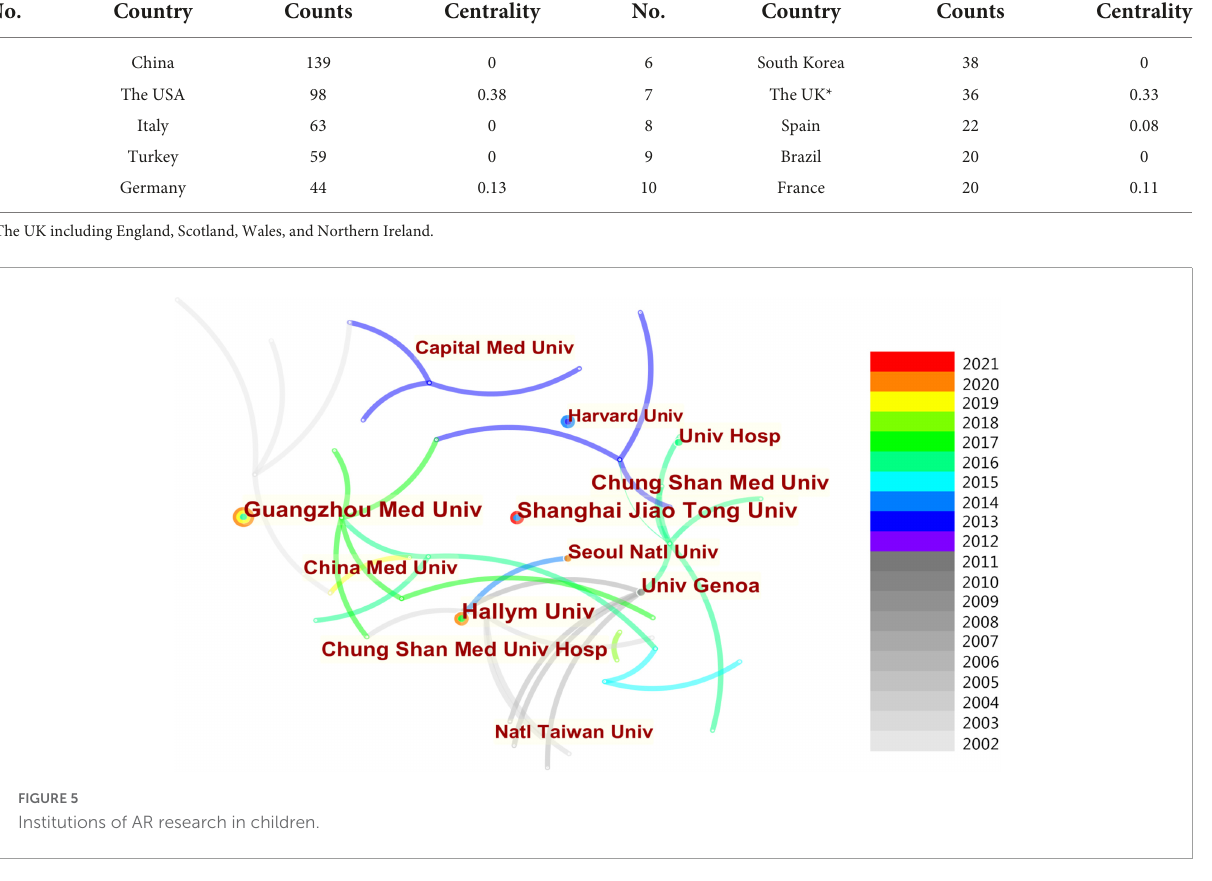
TABLE 3 Top 10 institutions in terms of the number of studies published in 2002–2021.